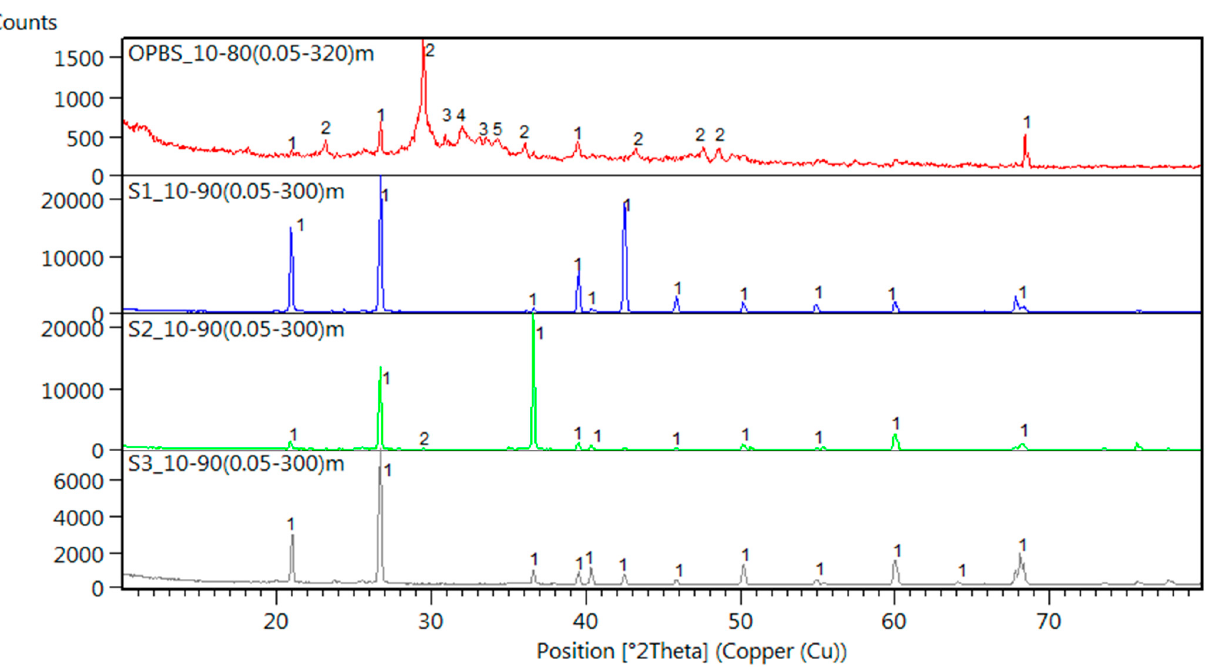
Figure 6. XRD analysis of the three soils, S1, S2, and S3, and OPBS: 1 = (SiO 2 ), 2 = (CaCO 3 ), 3 = (CaMg, (CO3) 2 ) 4 = (K 2 Ca (CO 3 ) 2 ), 5 =